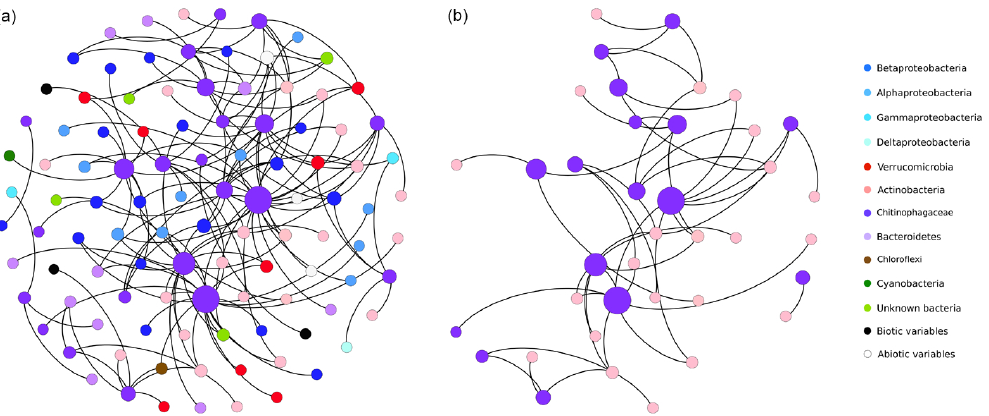
Figure 4. Subnetworks organized around bacterial OTUs closely related to Chitinophagaceae. Panel (a) presents the ensemble of co- occurrences between members of Chitinophagaceae and other bacteria. Panel (b) shows the specific linkages between Chitinophagaceae and Actinobacteria. The size of the nodes is proportional to node degree (the number of connections that a node has with other nodes).